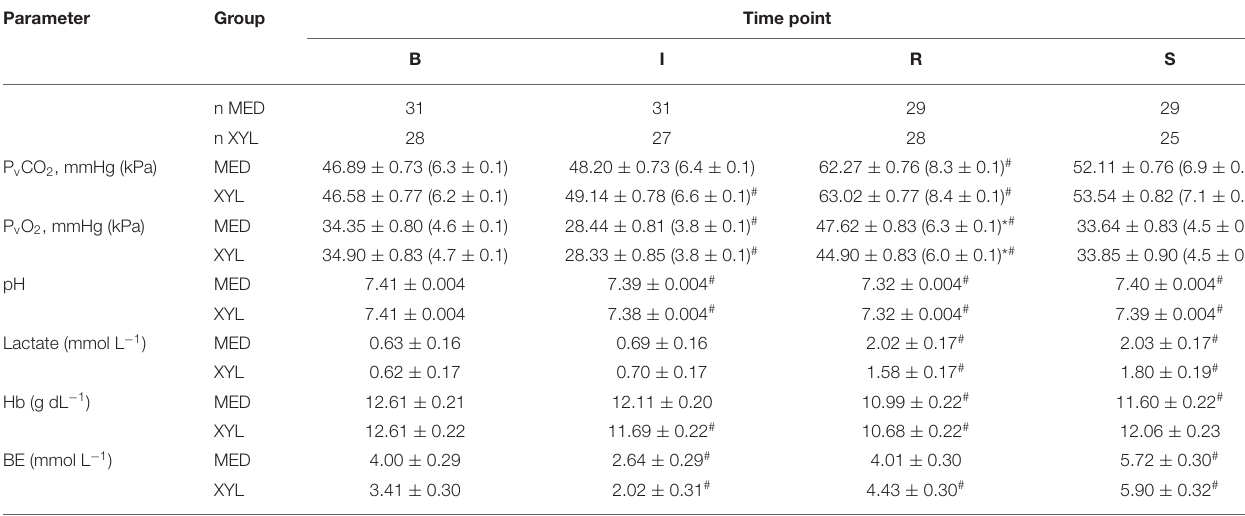
TABLE 1 | Mean ± SEM of venous blood-gas values, pH, lactate concentrations, total hemoglobin, base excess in horses with medetomidine isoflurane (group MED) or xylazine isoflurane (group XYL) balanced anesthesia. Parameter